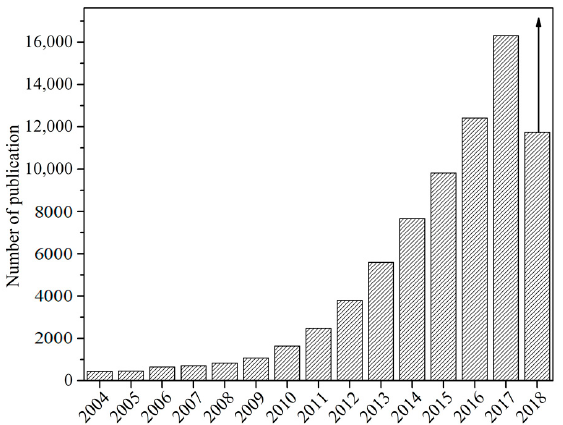
Figure 2. Publication trend in graphene chorology between 2004 and 2018 in ScienceDirect (this graph is plotted based on the simple searching of “graphene” at www.sciencedirect.com).